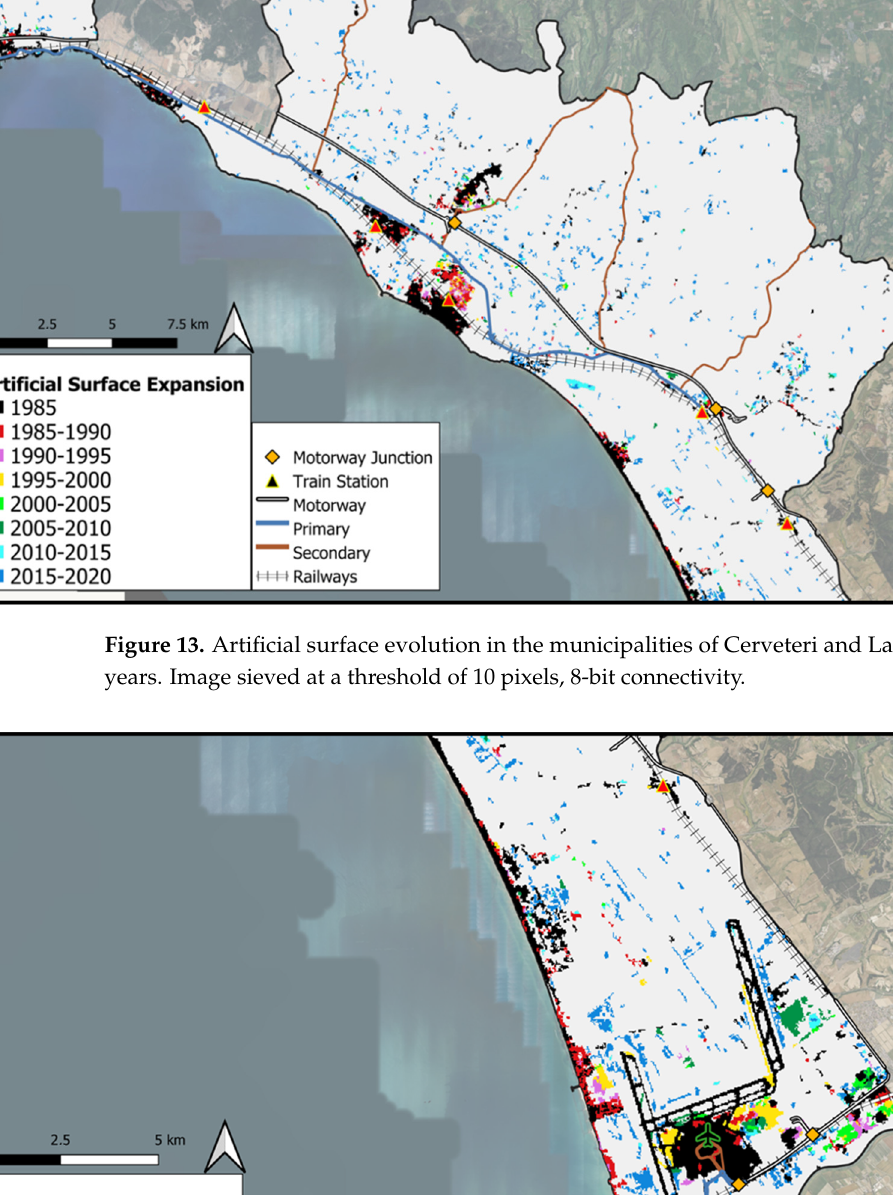
Figure 12. Artificial surface evolution in the municipalities of Civitavecchia and Santa Marinella through the years. Image sieved at a threshold of 10 pixels, 8-bit connectivity.